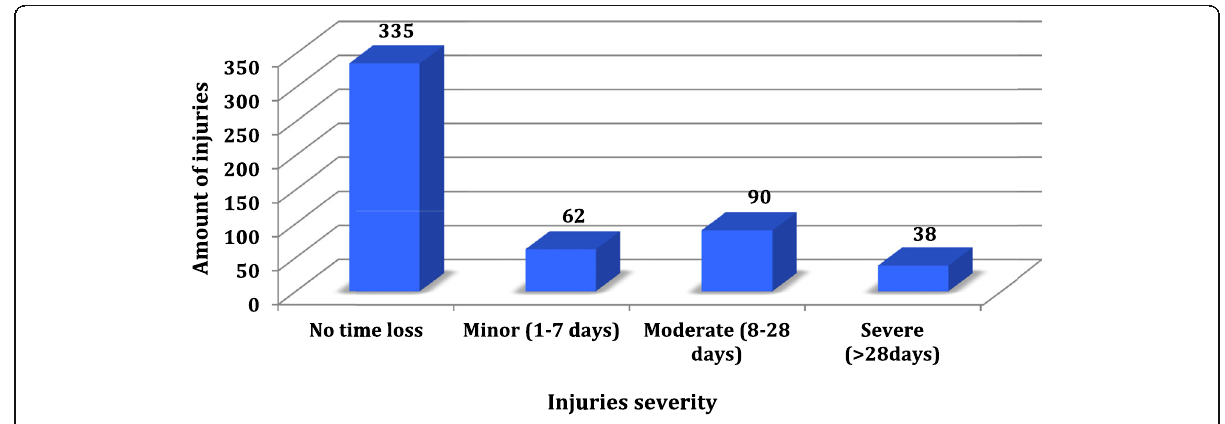
Fig. 7 Injuries severity distribution during the 7